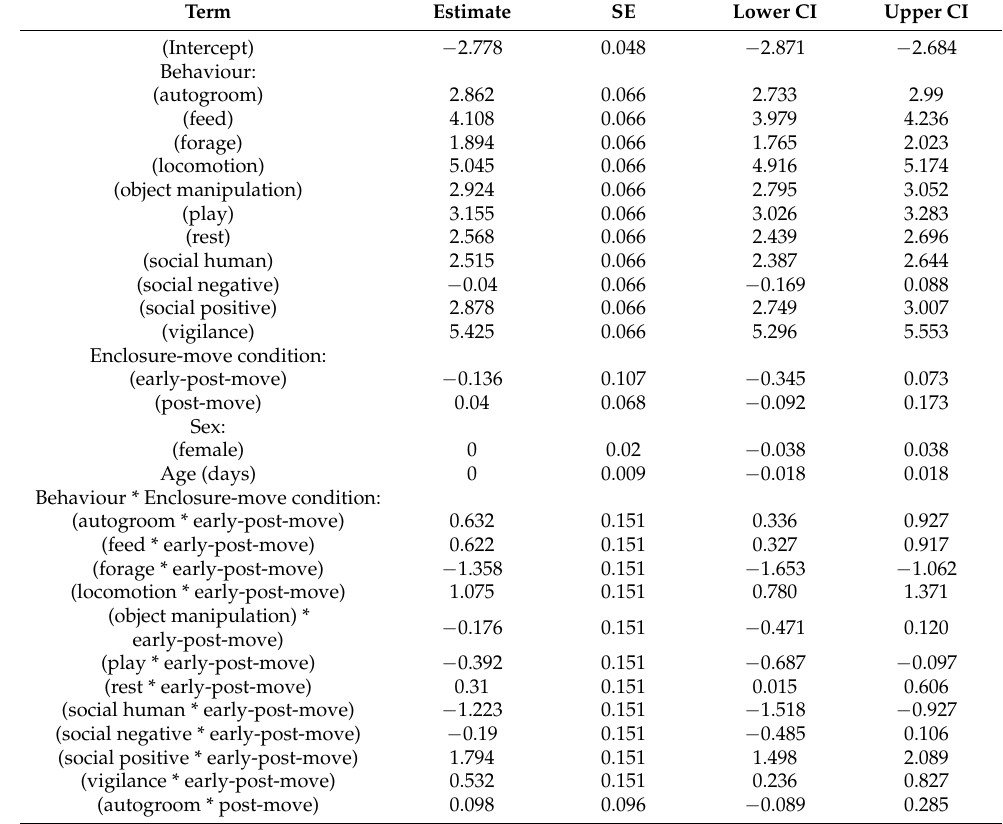
Table A5. Model 1 summary output: Sumatran orangutan activity